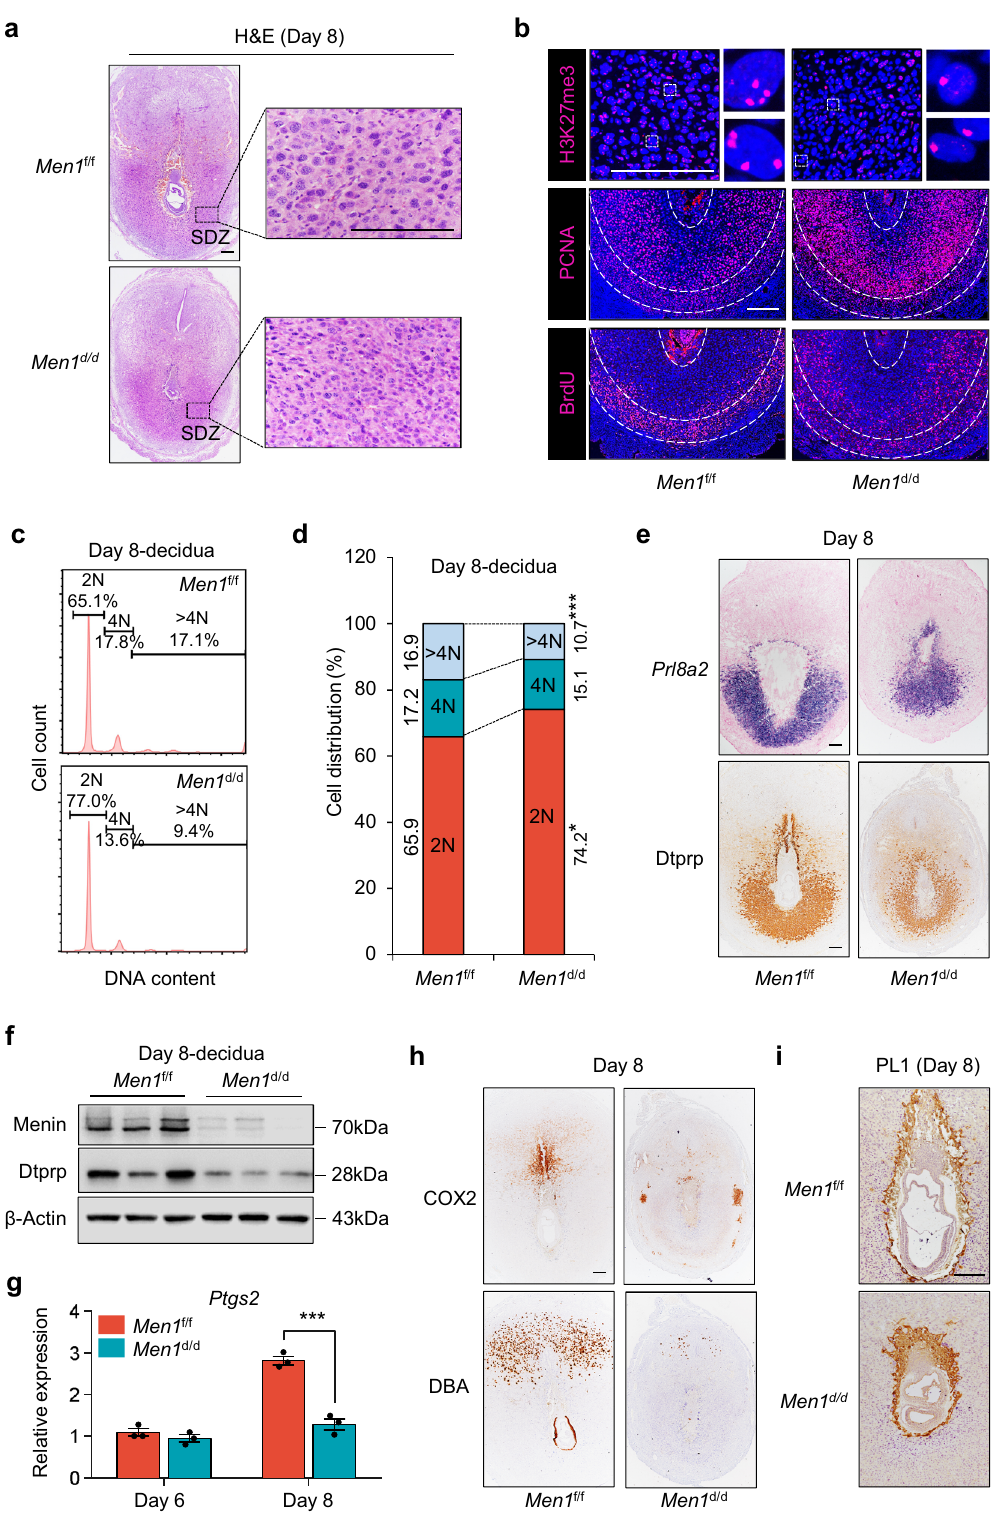
with Men1 deletion had an insuf fi cient terminal differentiation of stromal cells in the SDZ. Interestingly, the FGF signaling pathway that positively regulated cell proliferation was signi fi cantly enri- ched among the upregulated genes in Men1 d/d uteri. In contrast, the gene set responding to BMP which motivated differentiation